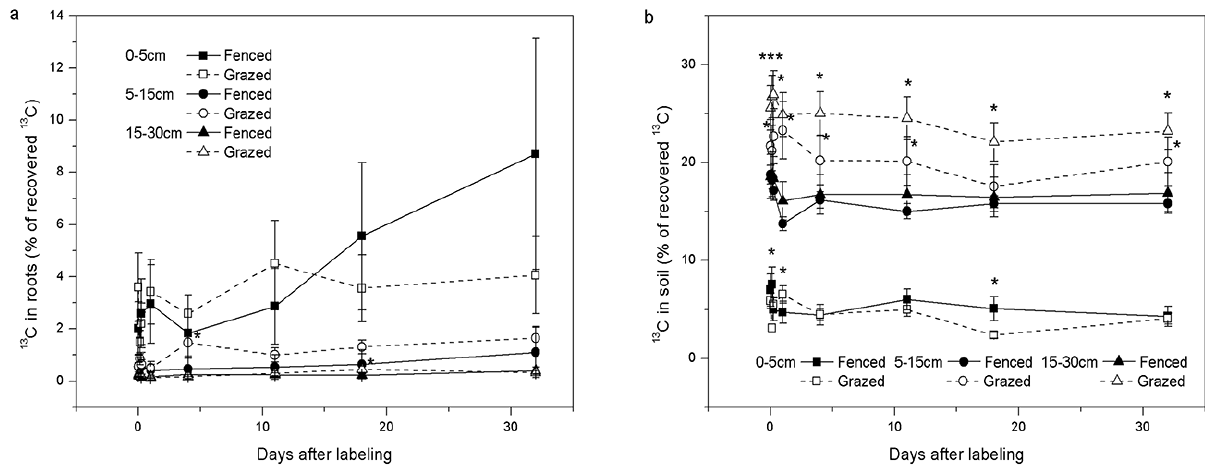
Figure 3. The vertical distribution dynamic of 13 C allocation (percentage of recovered 13 C) in roots (a) and soil (b) at layers of 0–5, 5–15 and 15–30cm in the fenced and control grazed meadows during the 32-day chase period. ∗ Indicates significant differences at P < 0 . 05 between the fenced and grazed meadows for each time step at each soil layer. Data are means ± standard deviation ( n =